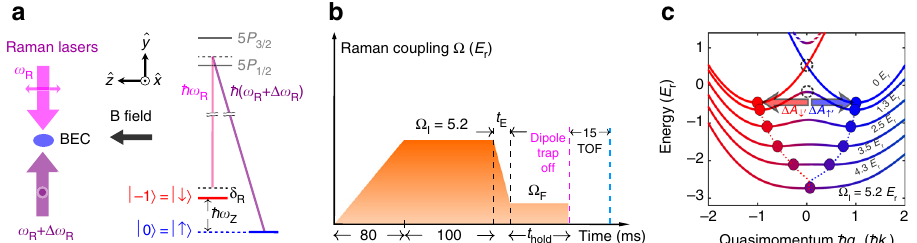
Fig. 1 Experimental setup and timing diagram used for the spin-dipole mode (SDM) experiments. a Linearly polarized Raman beams with orthogonal polarizations (indicated by the double-headed arrows along ^ z and ^ x ) counter-propagating along ^ y couple m F hyper fi ne sublevels (bare spin states) of 87 Rb atoms. The sublevels are Zeeman split by ħ ω Z ≈ ħ Δ ω R = h × (3.5 MHz) using a bias magnetic fi eld B ¼ B ^ z , which controls the Raman detuning δ R = ħ ( Δ ω R − ω Z ). b Experimental timing diagram: Raman coupling Ω (with an experimental uncertainty of <10%) is slowly ramped up in 80 ms to an initial value Ω Ω Ω is quickly lowered to a fi nal coupling I and held for 100 ms to prepare the BEC around the single minimum of the ground band at I as shown in c . Then, Ω F in time t E and held for some time t hold , during which we study the dynamics of the BEC in the dipole trap. Subsequently, the atoms are released for absorption imaging after a 15 ms time of fl ight (TOF), at the beginning of which a Stern – Gerlach process is performed for 9 ms to separate atoms of different bare spin states. c The ground band (solid lines) of synthetic SOC is calculated for a few representative Ω at δ R = 0. A higher band calculated for Ω = 1.3 E r is shown as dashed lines. The colors indicate the spin compositions, with red for #j i and blue for "j i . The ground band minima in quasimomentum marked by dots are identi fi ed with spin-dependent vector potentials ( A σ ), which shift in opposite directions as Ω is lowered into the double minima regime during t E . This generates spin-dependent synthetic electric fi elds E σ and thus excites the SDM and an AC spin current along the SOC direction in a trapped BEC. The upper (lower) dashed circle represents the region around q y = 0 in the double minima band at an exemplary Ω F = 0 ( Ω F = 1.3 E r ), from which the two (dressed) spin components of the BEC roll down towards the corresponding band minima in response to the application of E